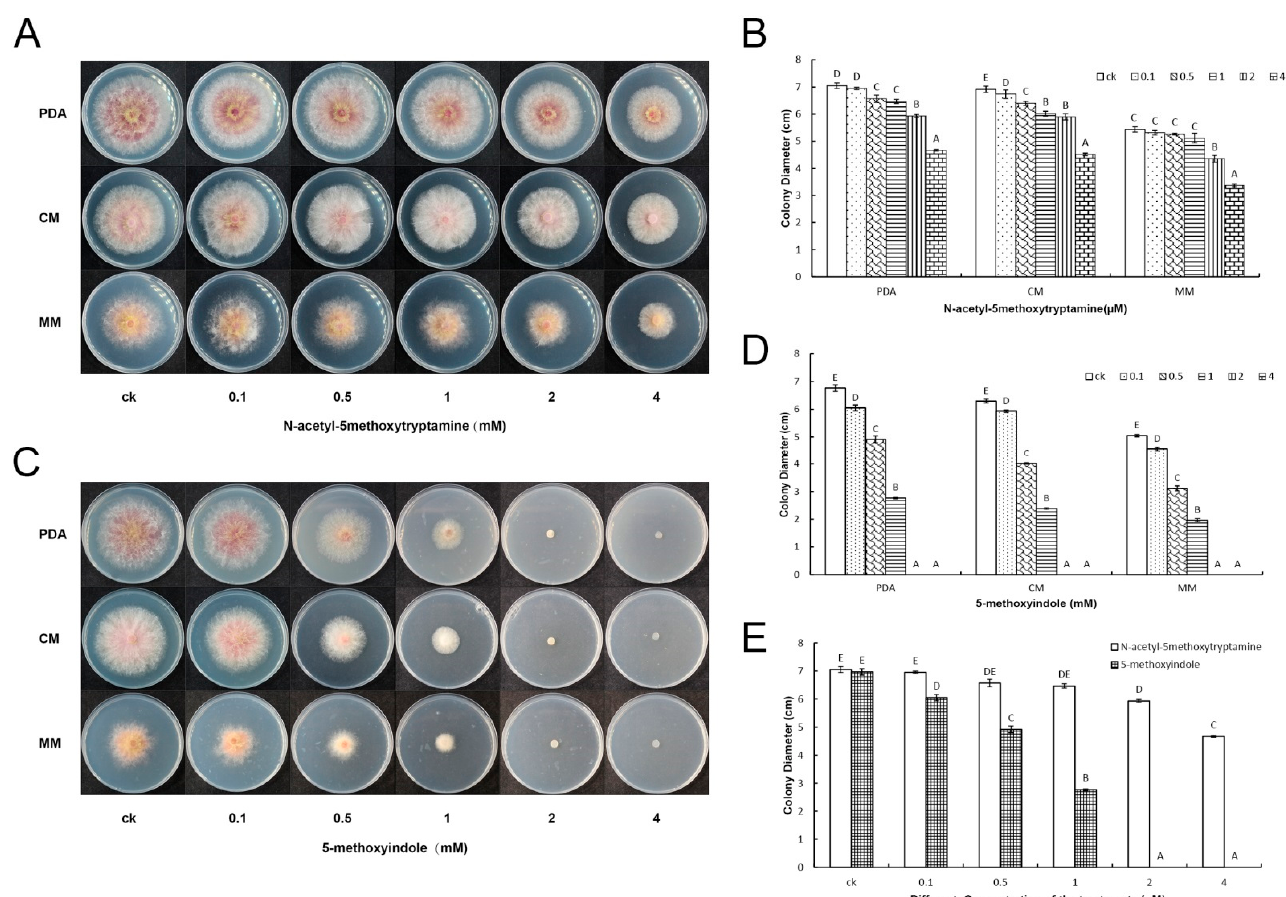
Figure 1. The antagonistic activity of melatonin and the 5-methoxyindole toward F. graminearum PH-1. ( A , B ) F. graminearum has grown in different media (PDA, CM and MM) containing different concentrations of melatonin (0, 0.1, 0.5, 1, 2 and 4 mM) grown for 3 days, and EC50 of melatonin were evaluated. ( C , D ) F. graminearum has grown in different medias containing different concentrations of 5-methoxyindole grown for 3 days, and the EC50 of 5-methoxyindole were evaluated. ( E ) The EC50 of melatonin and 5-methoxyindole were evaluated in the media of PDA. The experiment was repeated independently three times, and 0.05% (vol/vol) methanol/water served as the ck. The error bars represent the mean standard deviation of each treatment repeated three times with three replicates. The letters above the columns indicate significant differences. The significant difference between the treatments was determined through Tukey’s HSD test at p ≤ 0.05.